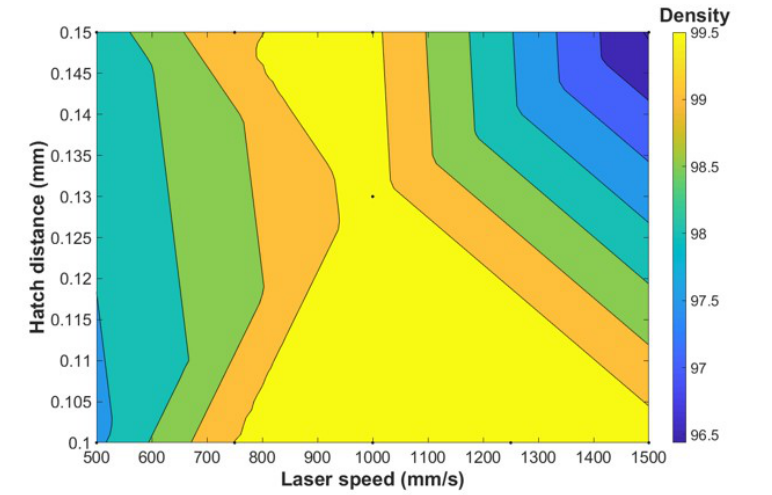
Figure 4. Surface plot showing density as a function of varying laser speed (mm/s) and hatch distance (mm).